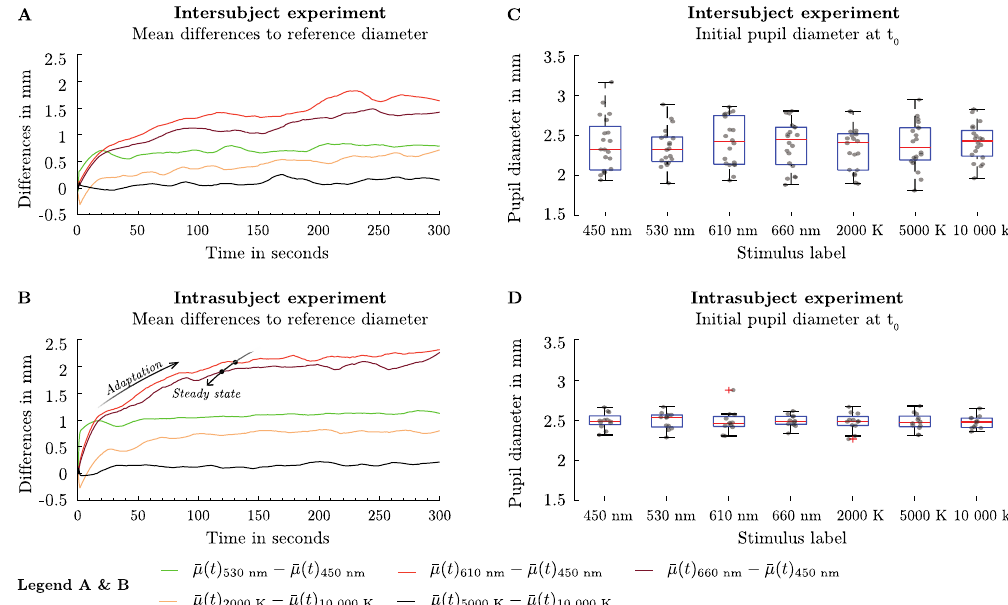
Figure 2. Adaptation behaviour of the pupil in our training data ( A ) Averaged temporal adaptation behaviour of the pupil as a function of different spectra from an intersubject experiment with polychromatic (n: 20, Age: 19–25, Mean age: 21.95 ± 1.73 y) and chromatic spectra (n: 20, Age: 19–25, Mean age: 22.2 ± 1.77 y). Subtracting the average pupil diameter from the reference pupil diameter at 450 nm shows that the pupil diameter’s equilibrium state is reached at different times. ( B ) Averaged temporal adaptation of the pupil light response from an intrasubject experiment (n: 1, repetitions: 12, Age: 33) with polychromatic and chromatic spectra. ( C ) The initial pupil diameters t 0 from the intersubject experiment are not significantly affected by the type of the used spectrum F ( 6, 66 ) = 0.85, p = 0.537 > .05 . ( D ) The measured pupil diameters t 0 in the intrasubject experiment are not significantly affected by the type of the spectrum F ( 6, 66 ) = 6.23 · 10 − 2 , p = 0.999 > .05